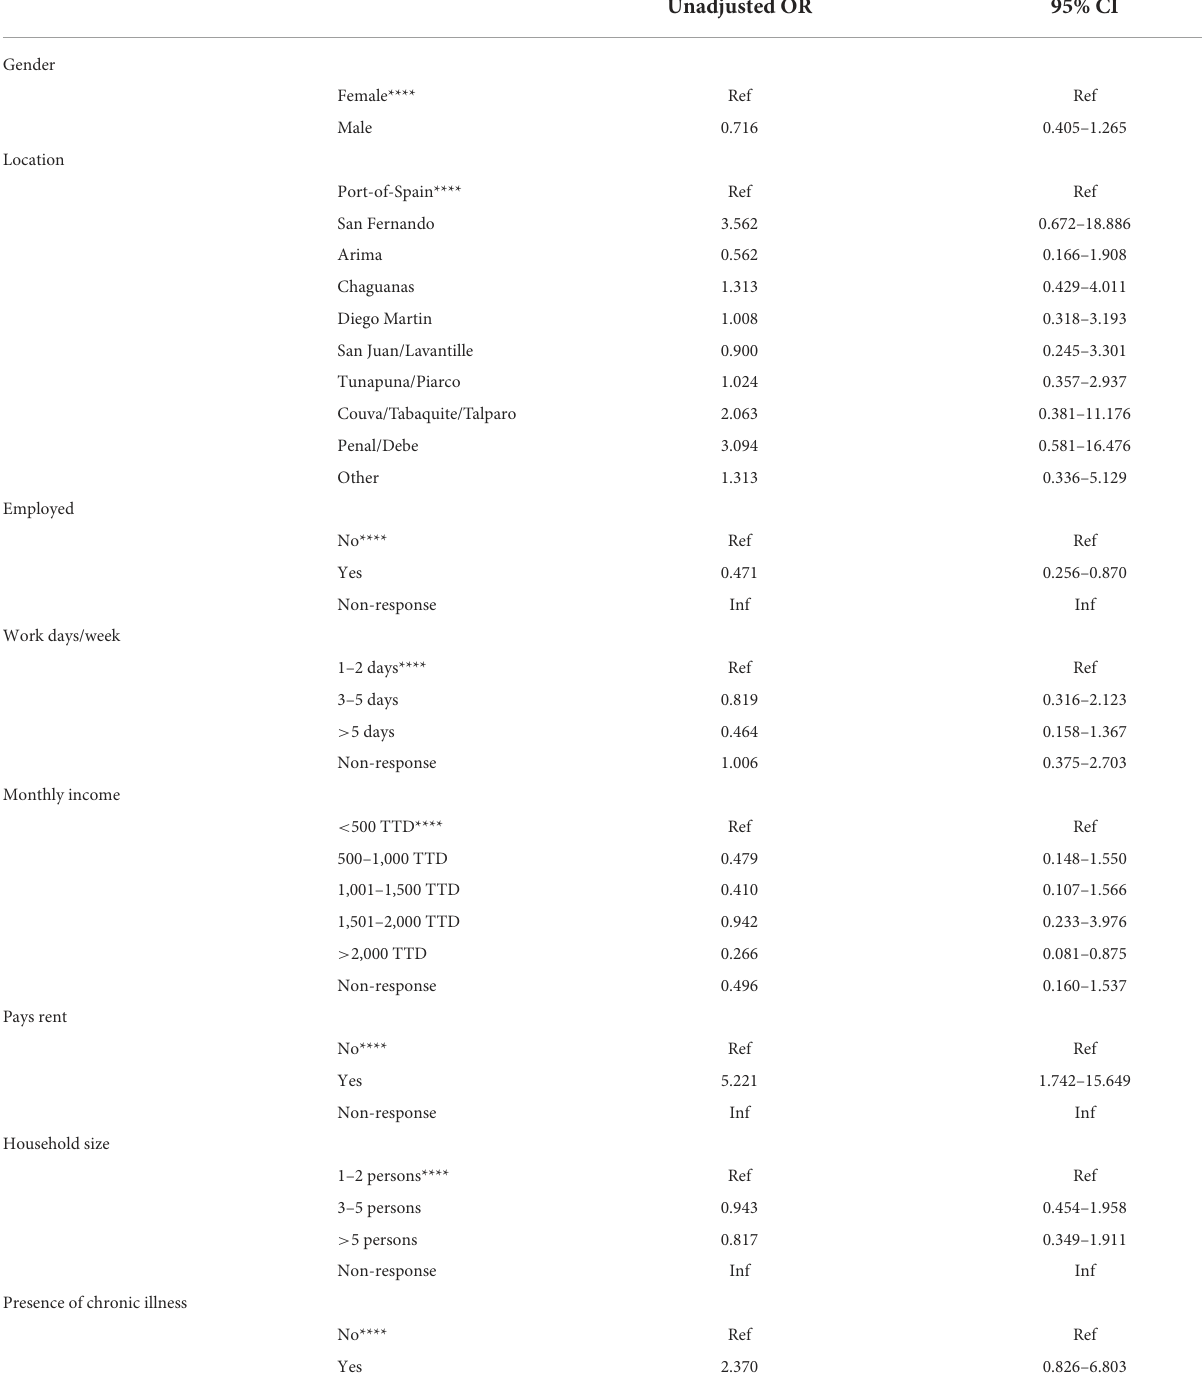
TABLE 4 Univariate associations of sociodemographic characteristics with food insecurity in terms of unadjusted odds ratios (OR) and 95% confidence intervals (CI).